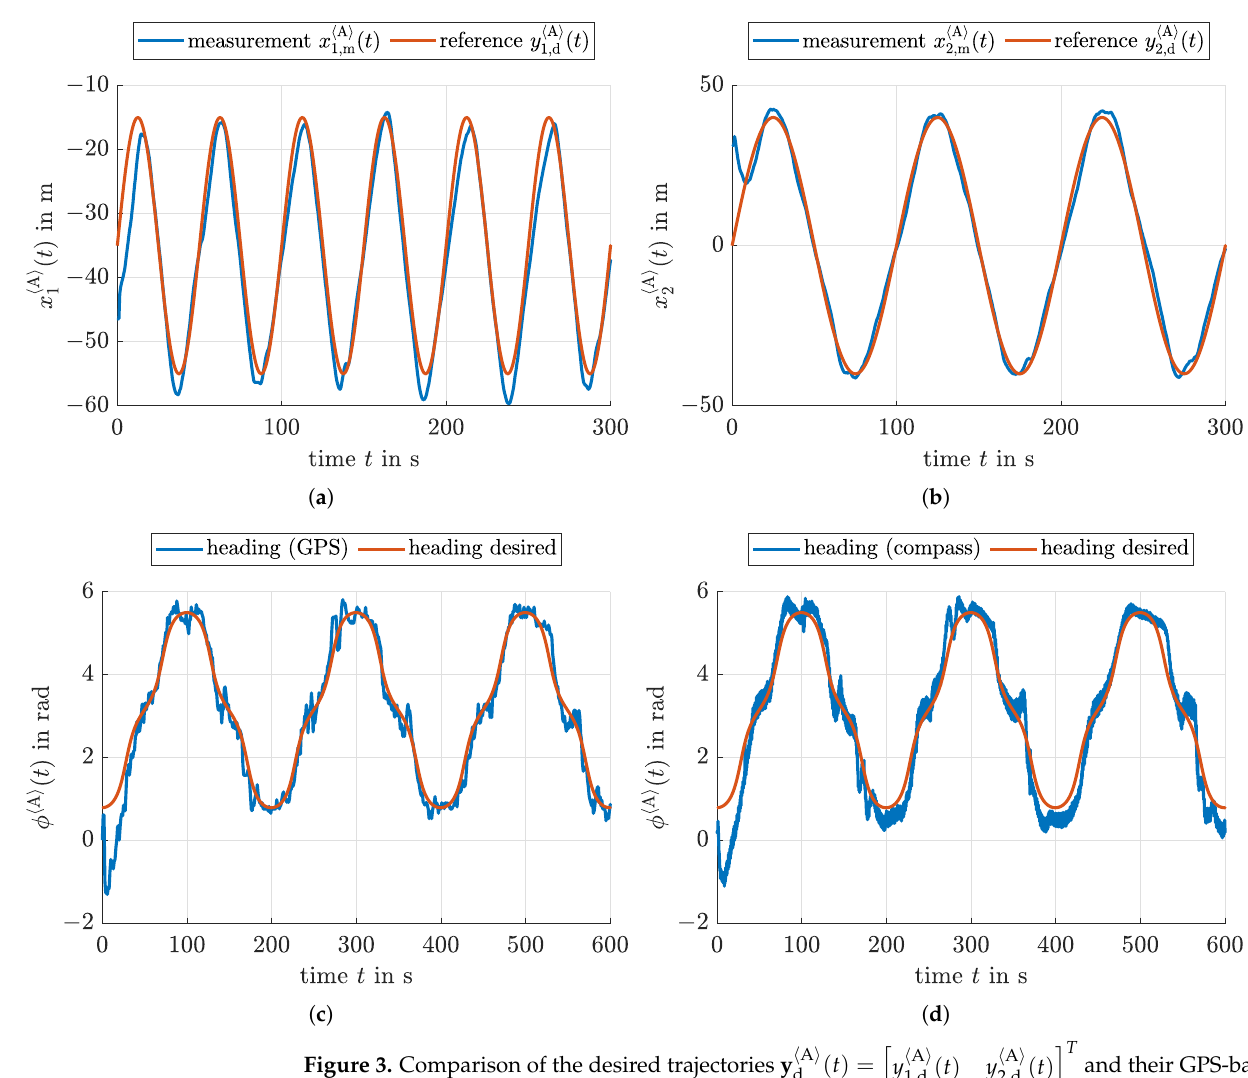
Figure 3. Comparison of the desired trajectories y measurements y measured and desired heading φ (cid:104) A (cid:105) ( t ) . ( a ) Time response of the position x 1 . ( b ) Time response of the position x 2 . ( c ) Desired heading vs. GPS-based reconstruction. ( d ) Desired heading vs. compass